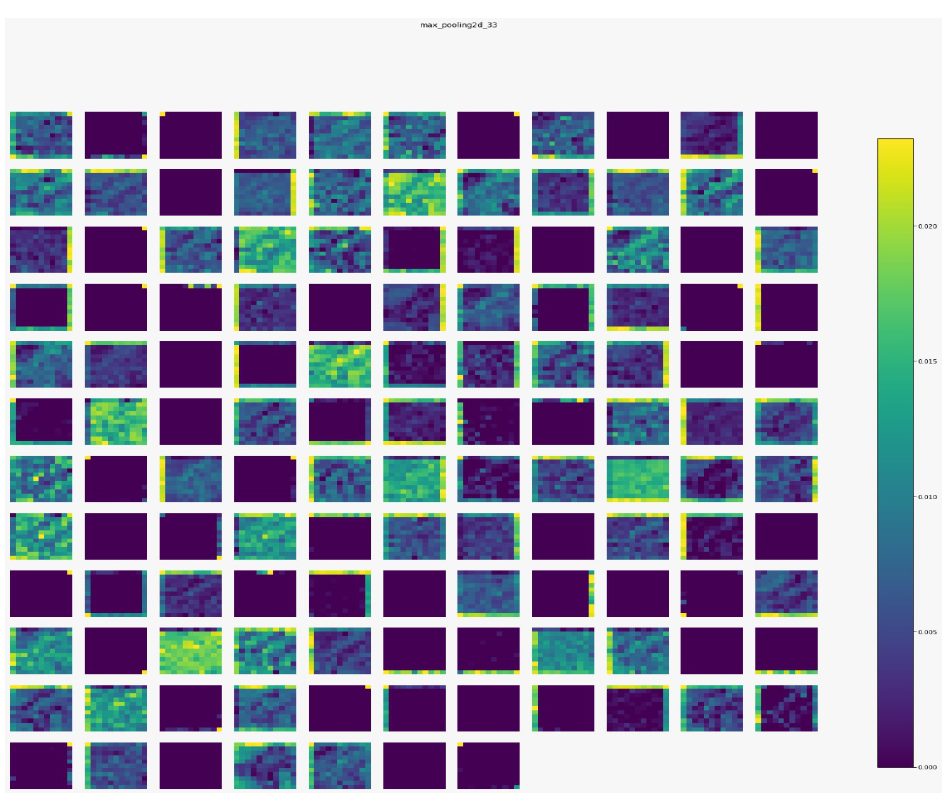
Figure 10. The output of the fourth Max pooling